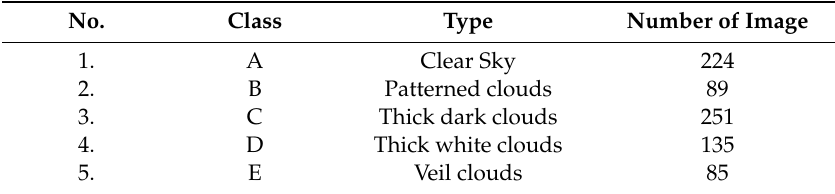
Table 3. SWIMCAT dataset.